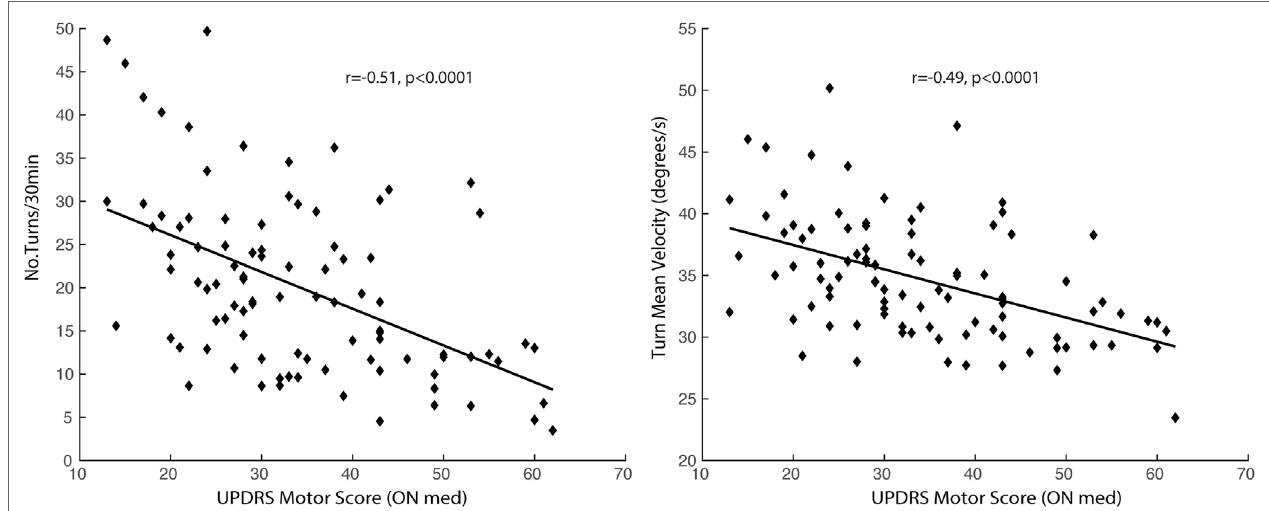
FigUre 3 | Association between disease severity, as measured by the UPDRS Motor Score, and quantity and quality of turning measured over 72